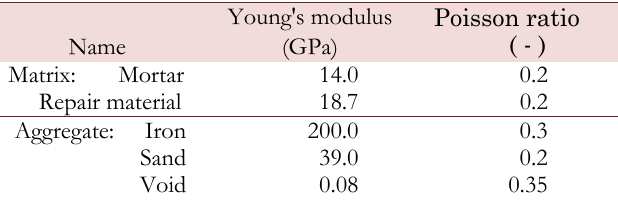
Table 4: Material properties of the elements. Figure 5: Tension softening diagram of mortar and repair.